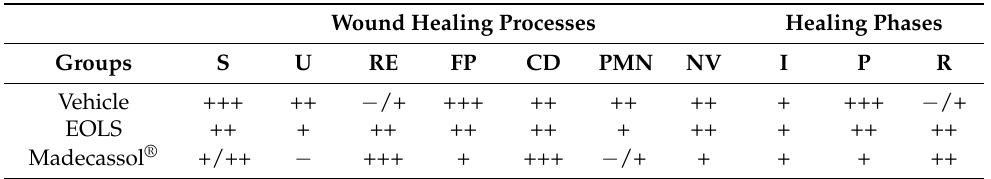
Table 5. The effects of different species of lavender essential oil on wound healing treatment.